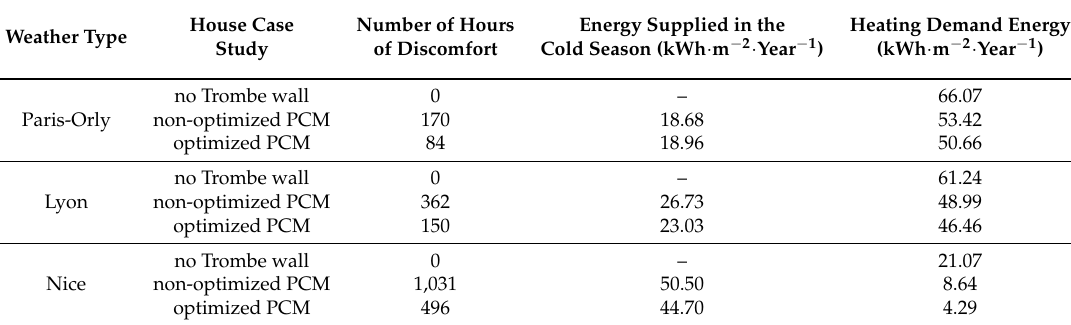
Table 7. Number of hours of thermal discomfort, energy supplied and heating